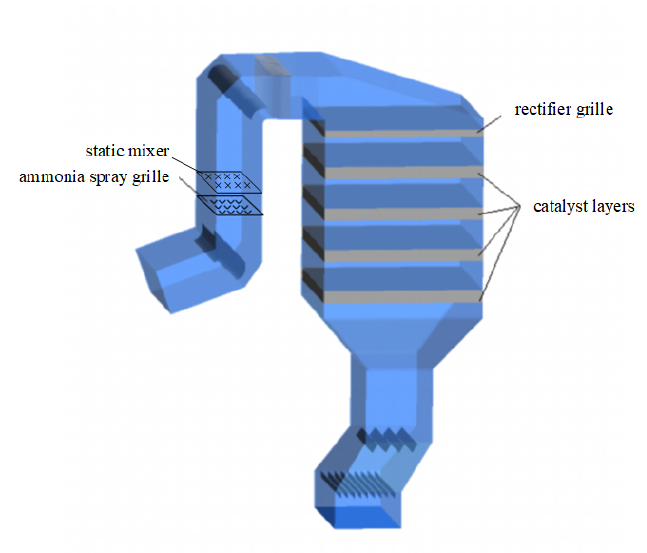
Figure 1. Calculation domain model diagram of original SCR denitration system